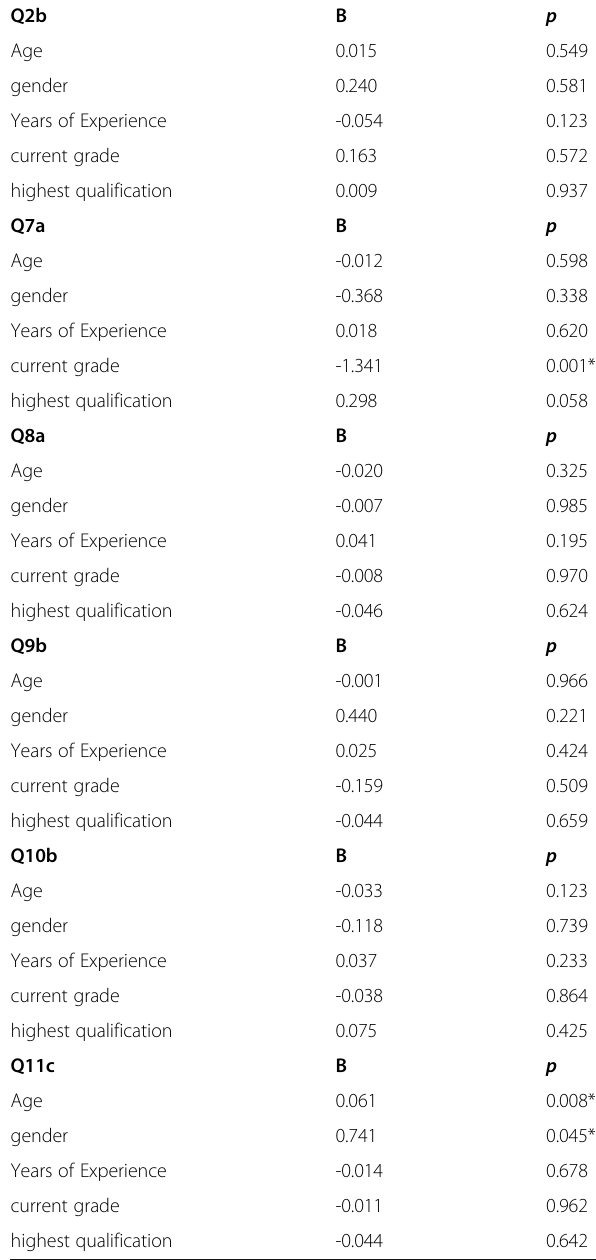
Table 3 Logistic regression analysis showing factors predicting responses with high